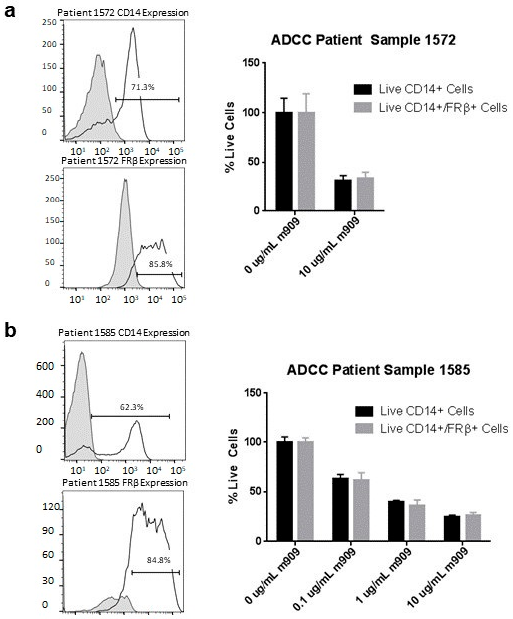
Figure 7. Expression of FR β and ADCC on primary ovarian ascites samples. ( a ) CD14 and CD14/FR β expression data for patient sample 1572. ADCC data for patient sample 1572 showing a significant decrease in live FR β expressing cells. ( b ) CD14 and CD14/FR β expression on patient sample 1585. ADCC data for patient sample 1585 showing a dose-dependent response to m909 administration. All samples were tested in triplicate and all graphs were normalized to wells with 0 μ g/mL of m909. Error bars represent standard deviation.